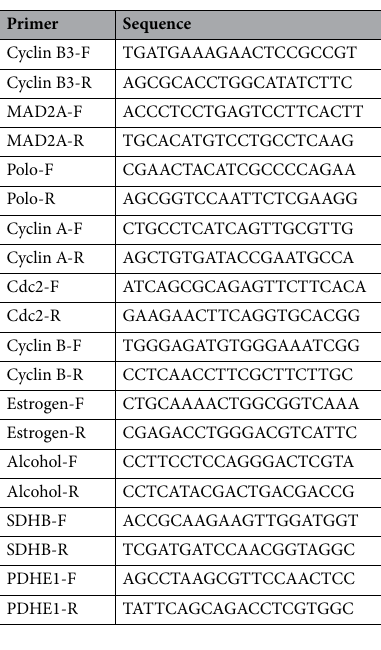
Table 2. Primers used for qPCR